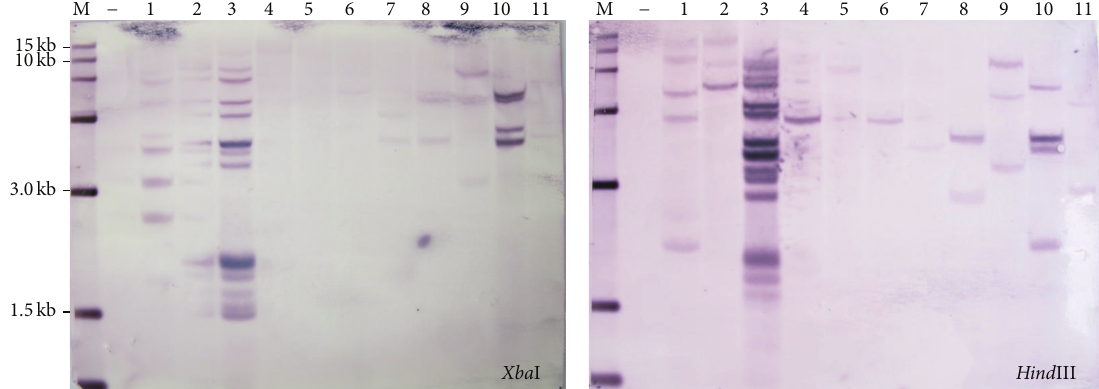
Figure 4: Southern blot hybridization of transgenic plants. The soybean genomic DNA was sampled from 11 independent events in the T 2 generation (1–11) and digested with two different restriction enzymes, Xba I and Hind III, and hybridized with the bar probe labeled with